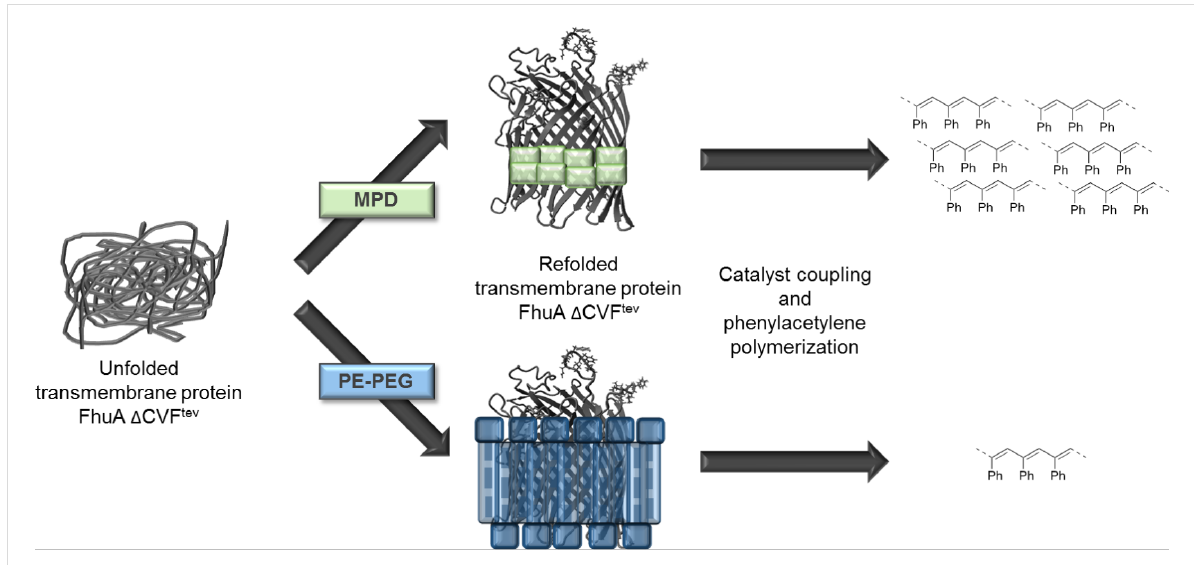
Figure 1: Phenylacetylene polymerization of FhuA Δ CVF tev [29] refolded in a polymer or small amphiphilic molecule. Refolding agents are essential to solubilize transmembrane proteins and keep membrane proteins refolded by shielding hydrophobic residues in aqueous environments. Refolding of the open channel protein FhuA Δ CVF tev was on one hand achieved with polyethylene–polyethyleneglycol (PE–PEG), which is a micelle-forming detergent. In contrast, refolding of FhuA Δ CVF tev with 2-methyl-2,4-pentanediol (MPD) prevents micelle formation and leads to increased yield and molecular weight of the corresponding polymer.